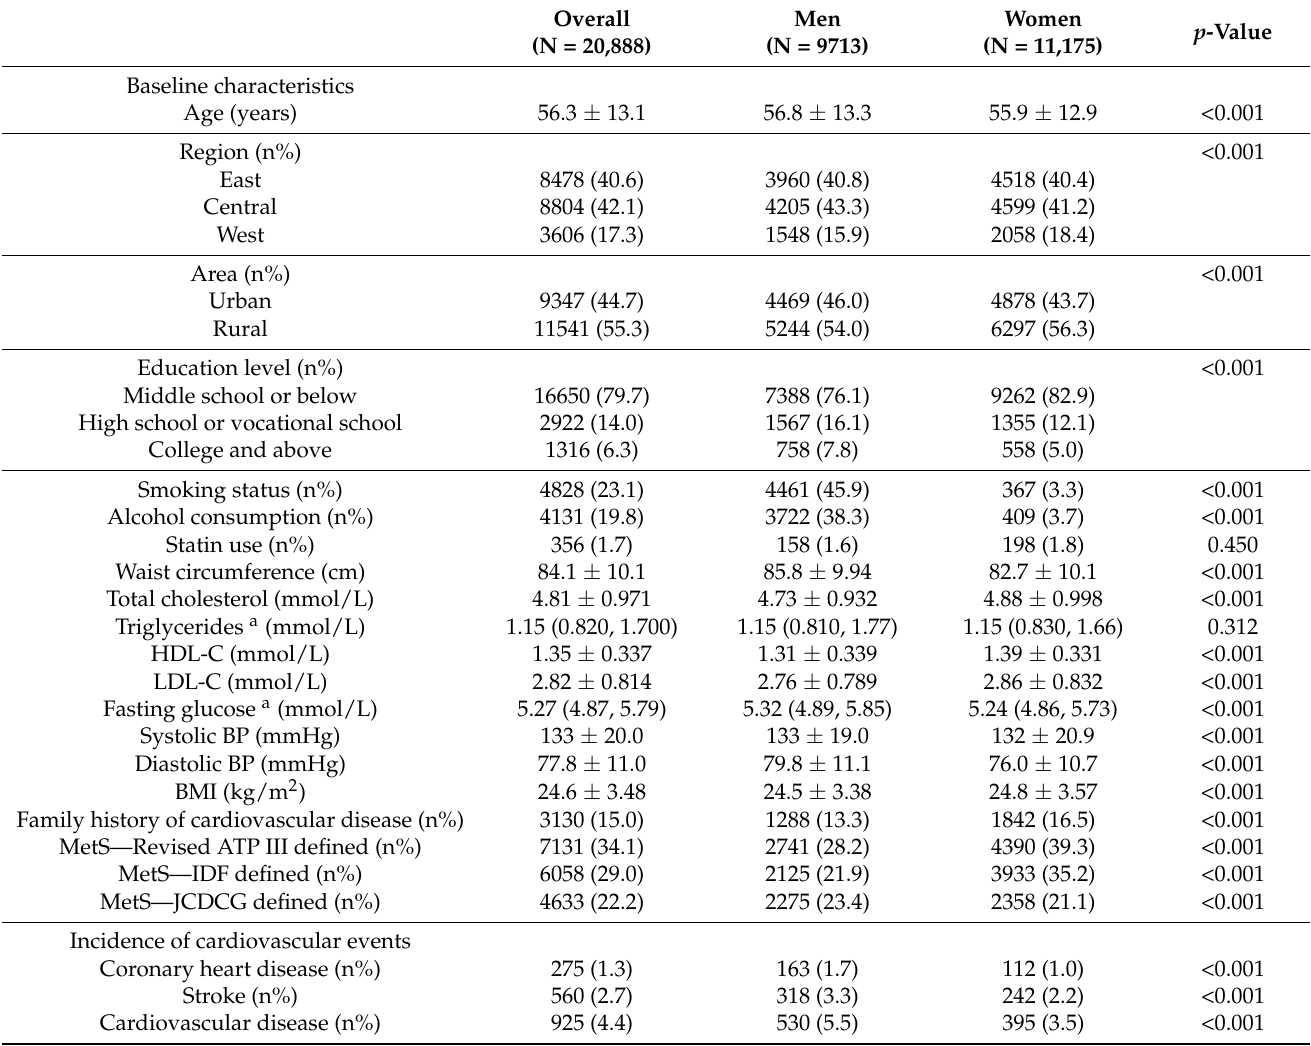
Table 2. Baseline characteristics and incidence of cardiovascular events of the study